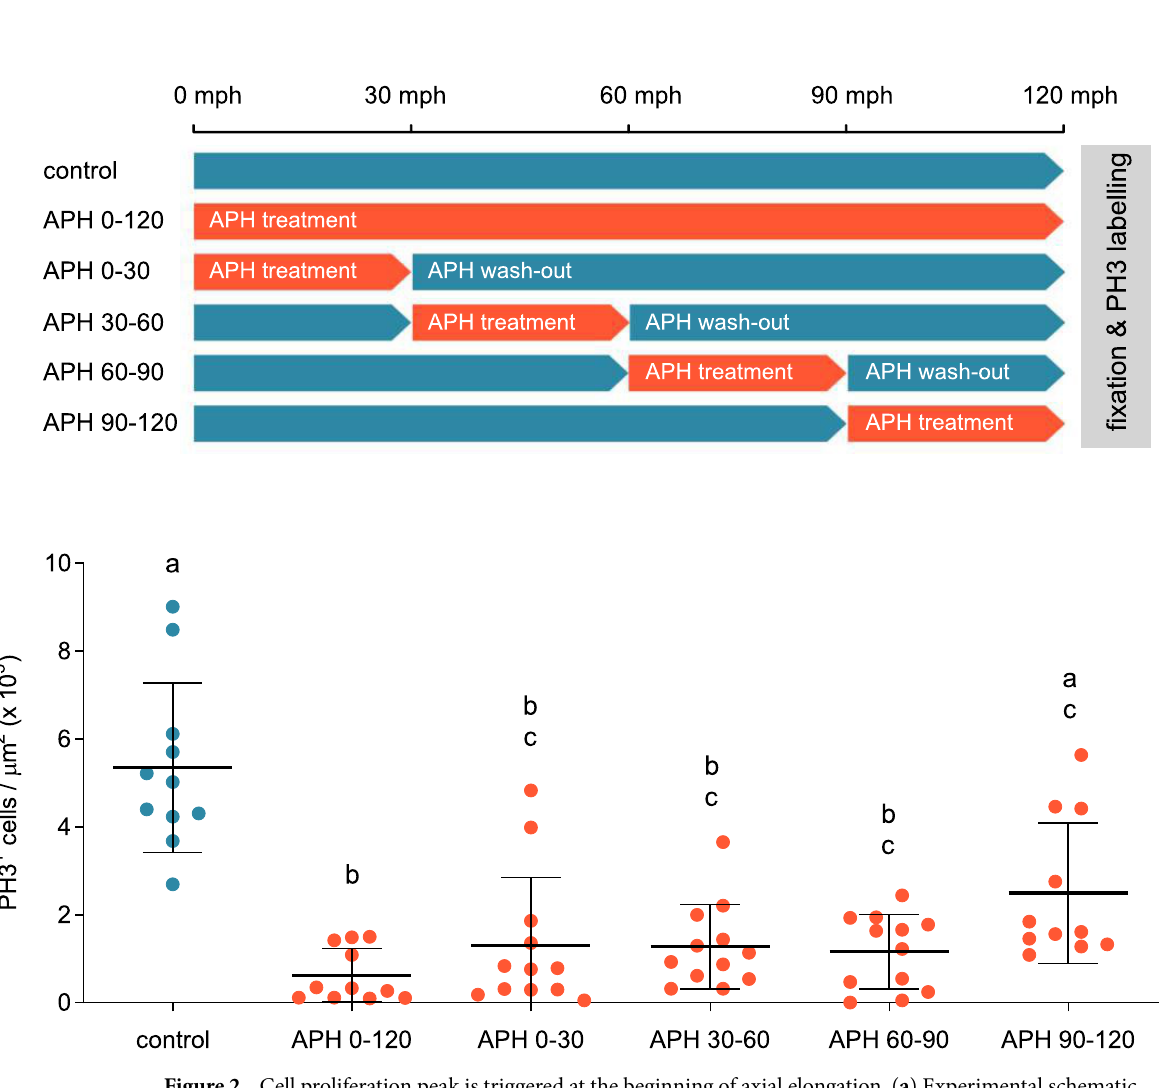
Figure 2. Cell proliferation peak is triggered at the beginning of axial elongation. ( a ) Experimental schematic for time window Aphidicolin treatments. Aphidicolin incubation windows and washouts are highlighted in orange and blue, respectively. All treatments lasted 2 h and were followed by embryo fixation and anti-PH3 antibody staining. ( b ) Number of PH3 + cells (normalized by area × 10 3 ) measured at 120 mph after each treatment. Error bars indicate SD of the mean (n = 11–12). Different letters represent groups with statistically significant differences according to a Kruskal–Wallis test and Dunn’s multiple comparisons test ( p < 0.05). Corresponding p -values are showed in Supplementary Table